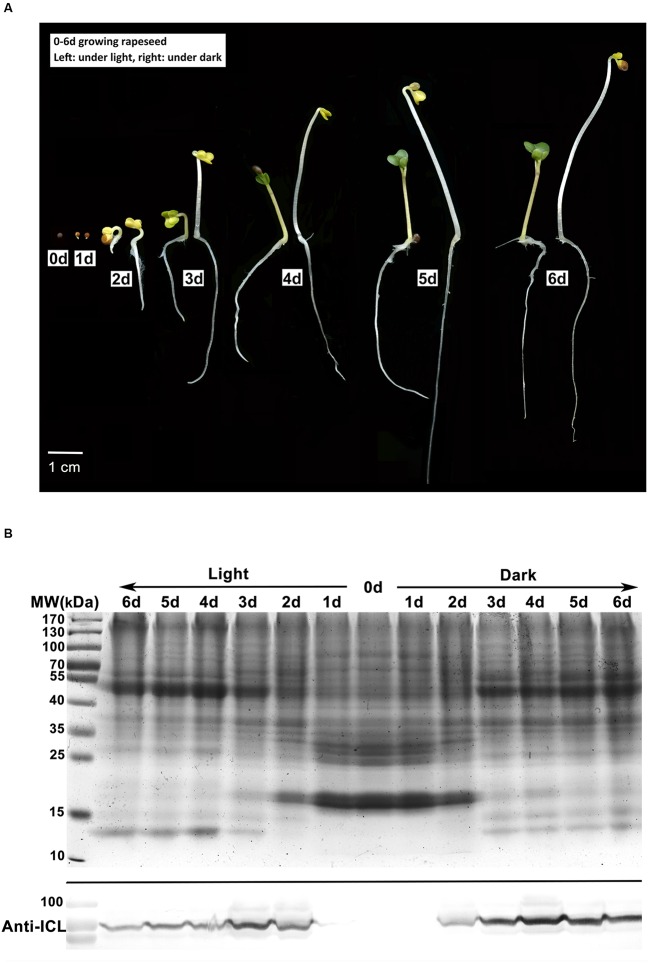
Characterization of rapeseed germination and postgerminative growth. (A) Rapeseed grown under light or dark conditions for 0–6 days. Left, under light; right, under dark. (B) Western blot analysis of isocitrate lyase (ICL) in cotyledons. Upper, SDS-PAGE gel stained with Coomassie brilliant blue as the loading control, 50 μg protein was loaded for each lane. Lower, proteins were probed with anti-ICL antibody.